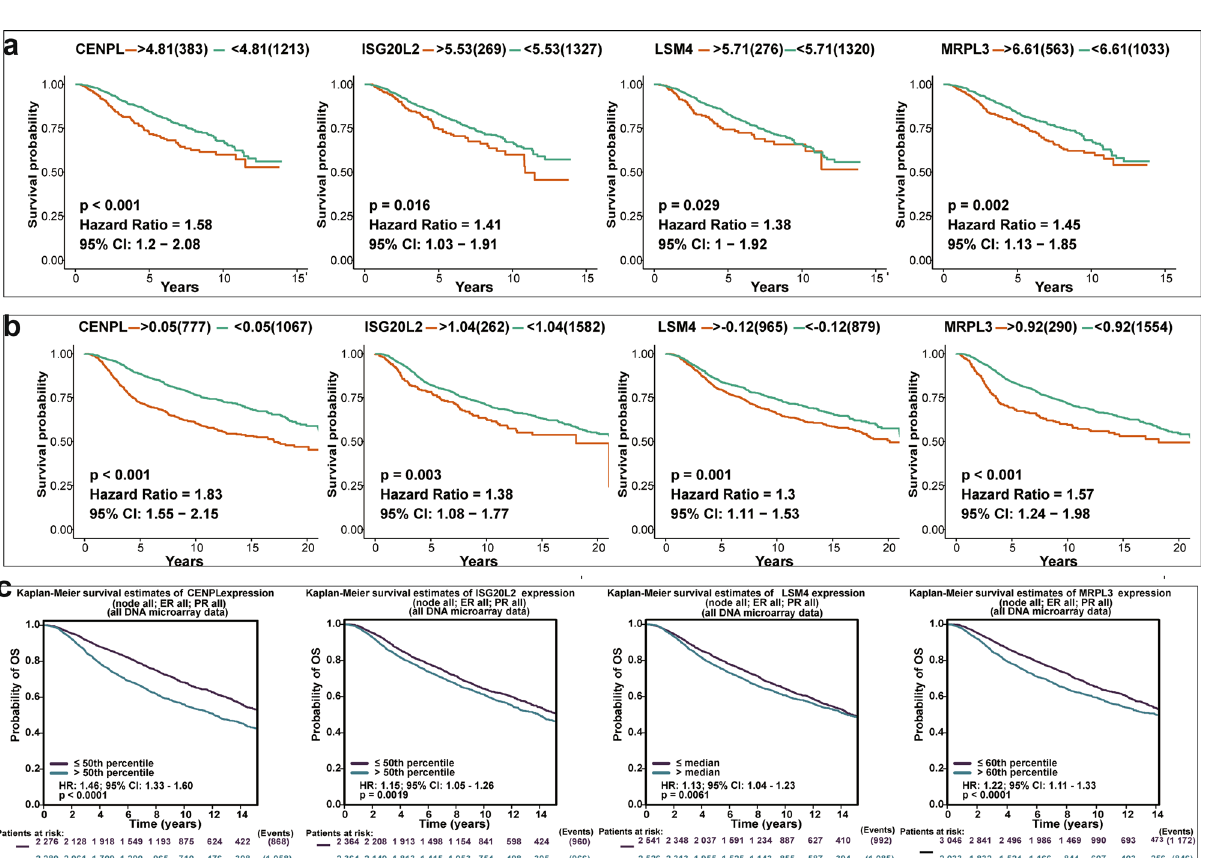
Figure 6. The prognostic value analysis of four novel hub genes in breast cancer based on ( a) TCGA_GEO BRCA dataset, ( b) METABRIC dataset, ( c) bc-GenExMiner v4.6 Platform. Expression levels of CENPL, ISG20L2, LSM4 and MRPL3 are significantly associated with the OS of patients in breast cancer (all P < 0.05, HR ˃